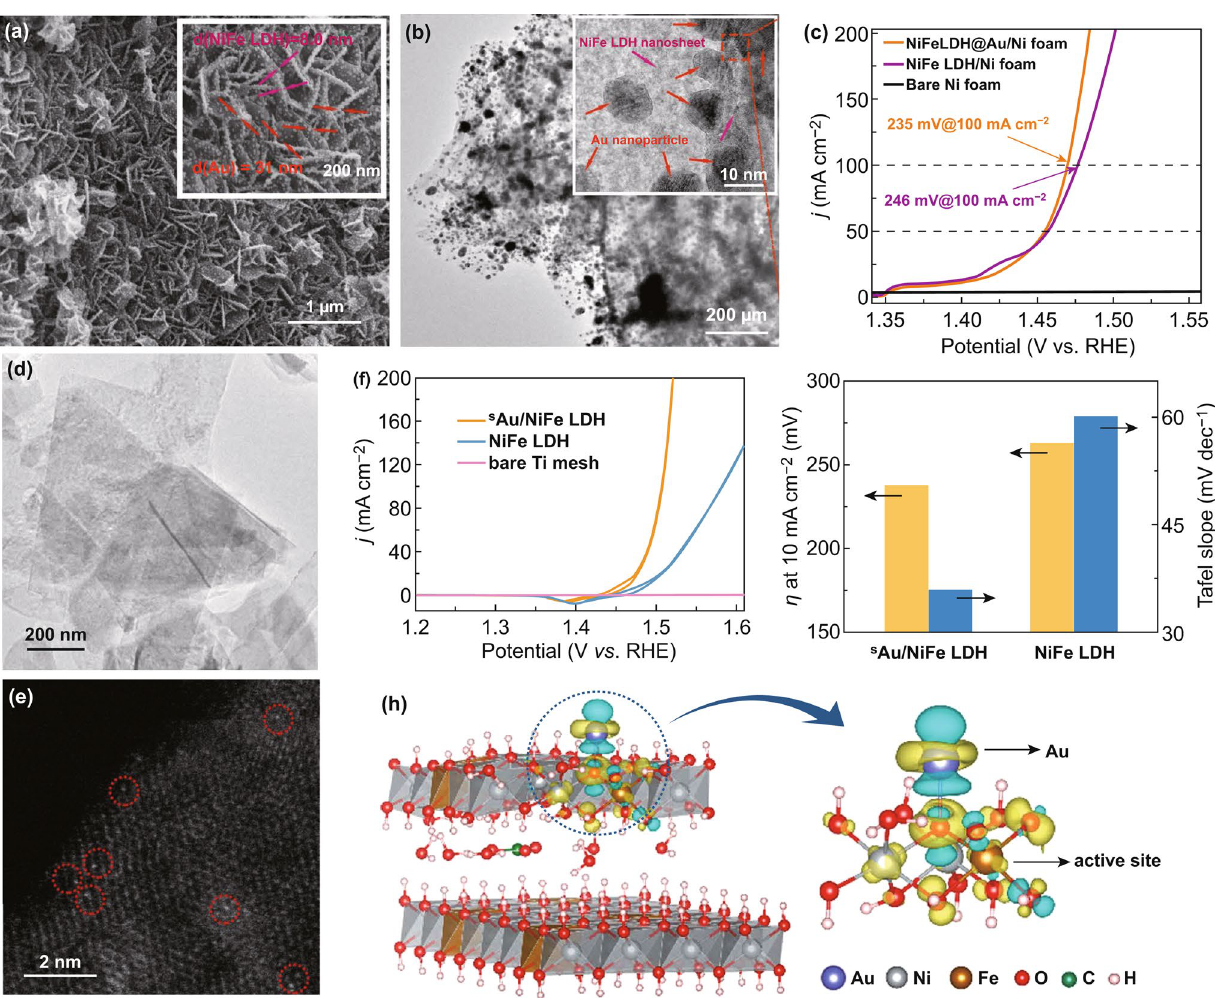
Fig. 7 a SEM images, b TEM images of NiFe LDH@Au/Ni foam. c LSV curves of as‑prepared catalysts at 1 mV s −1 in 1.0 M KOH. Repro‑ duced with permission of Ref. [92]. Copyright 2017 American Chemical Society. d TEM image, e HAADF‑STEM image of sAu/NiFe LDH. f Cyclic voltammetry (CV) curves of the catalysts at 5 mV s −1 with 95% iR compensation in 1 M KOH. g Overpotential (η) at 10 mA cm −2 and Tafel slope of pure NiFe LDH and sAu/NiFe LDH. h Differential charge densities of NiFe LDH supported with and without Au atom. Repro‑ duced with permission of Ref. [97]. Copyright 2018 American Chemical